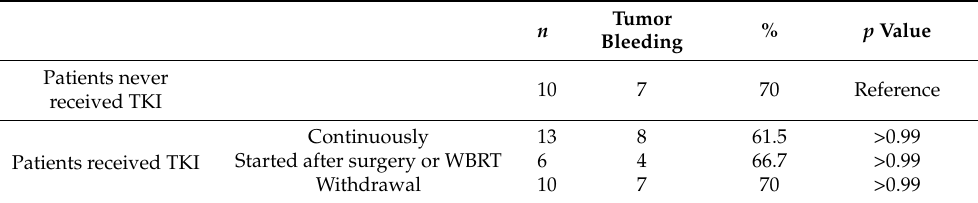
Table 2. Intra-tumoral bleeding rate in brain